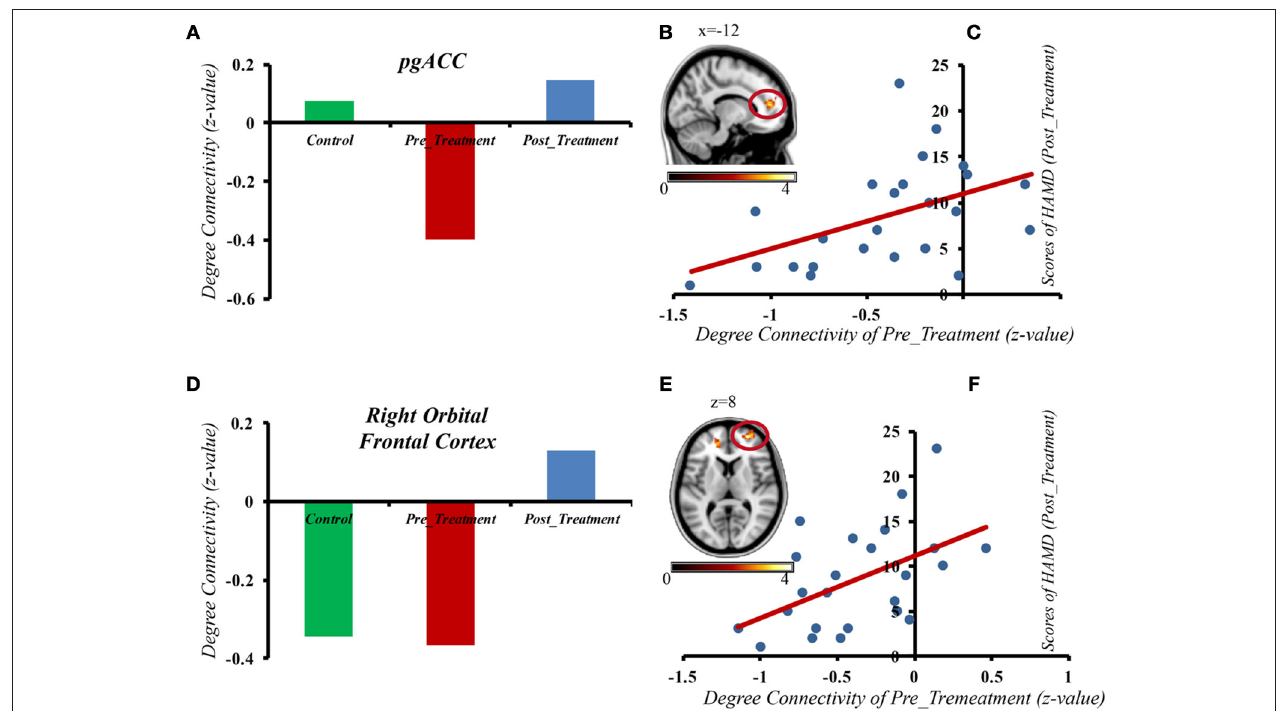
FIGURE 3 | The gFCD in the pgACC and right orbital frontal cortex of depressive patients before MECT shows a positive correlation with HAMD scores after treatment. (A) gFCD in pgACC in three different groups. (B) gFCD in pgACC. (C) The gFCD in the pgACC of depressive patients pre MECT shows a positive correlation with HAMD scores post treatment. (D) gFCD in Right Orbital Frontal Cortex in three different groups. (E) gFCD in Right Orbital Frontal Cortex. (F) The gFCD in the Right Orbital Frontal Cortex of depressive patients pre MECT shows a positive correlation with HAMD scores post